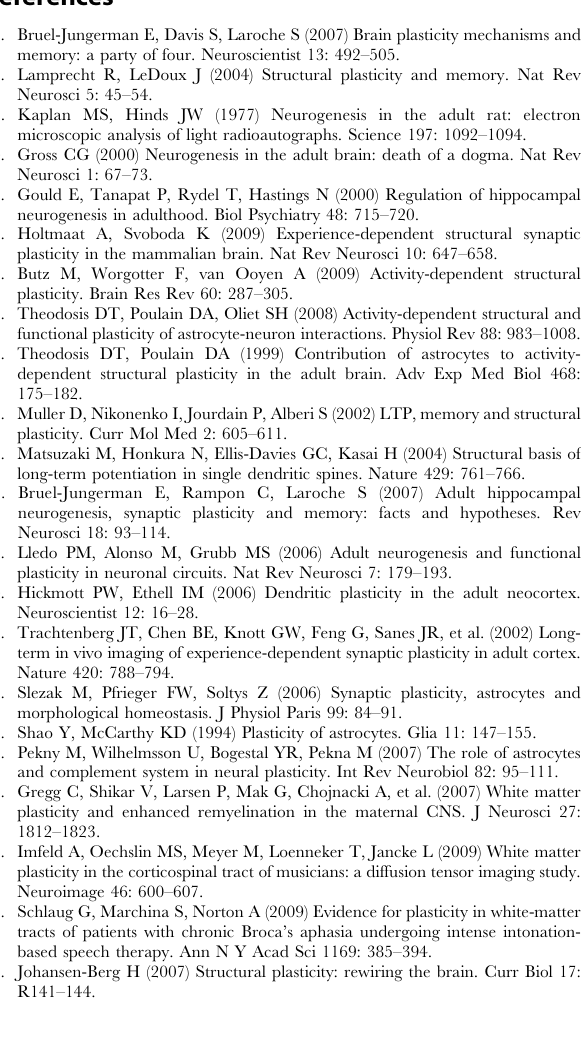
normalization: ( d ) mean FA, ( e ) standard deviation, ( f ) standard deviation divided by the mean. Note that registration was followed by significant misalignment between the images, resulting in high standard deviations for the border between white and gray matter and between gray matter and cerebrospinal fluid ( b, c ). After normalization these misalignments disappeared, as reflected by similarity of the standard deviations across the brain ( e, f